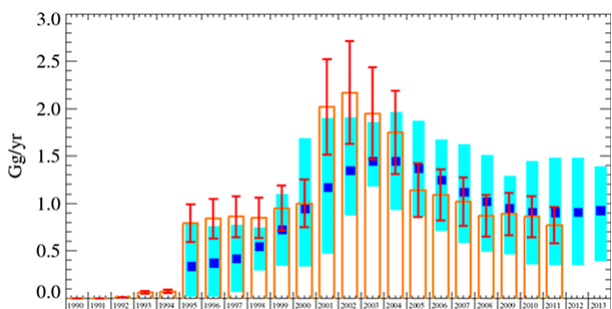
Figure 8. Emission (Ggyr − 1 ) estimates for HFC-152a from north- western Europe. The blue uncertainty bars represent the 5th and 95th percentiles of the InTEM estimates (rolling 3-yr averages). The orange bars and associated uncertainty are the UNFCCC inventory estimates for the NWEU region. (25% uncertainty is estimated by the UK in their National Inventory Report (NIR) submission to the UNFCCC, the same uncertainty was assumed for northwestern Eu- rope given the lack of additional